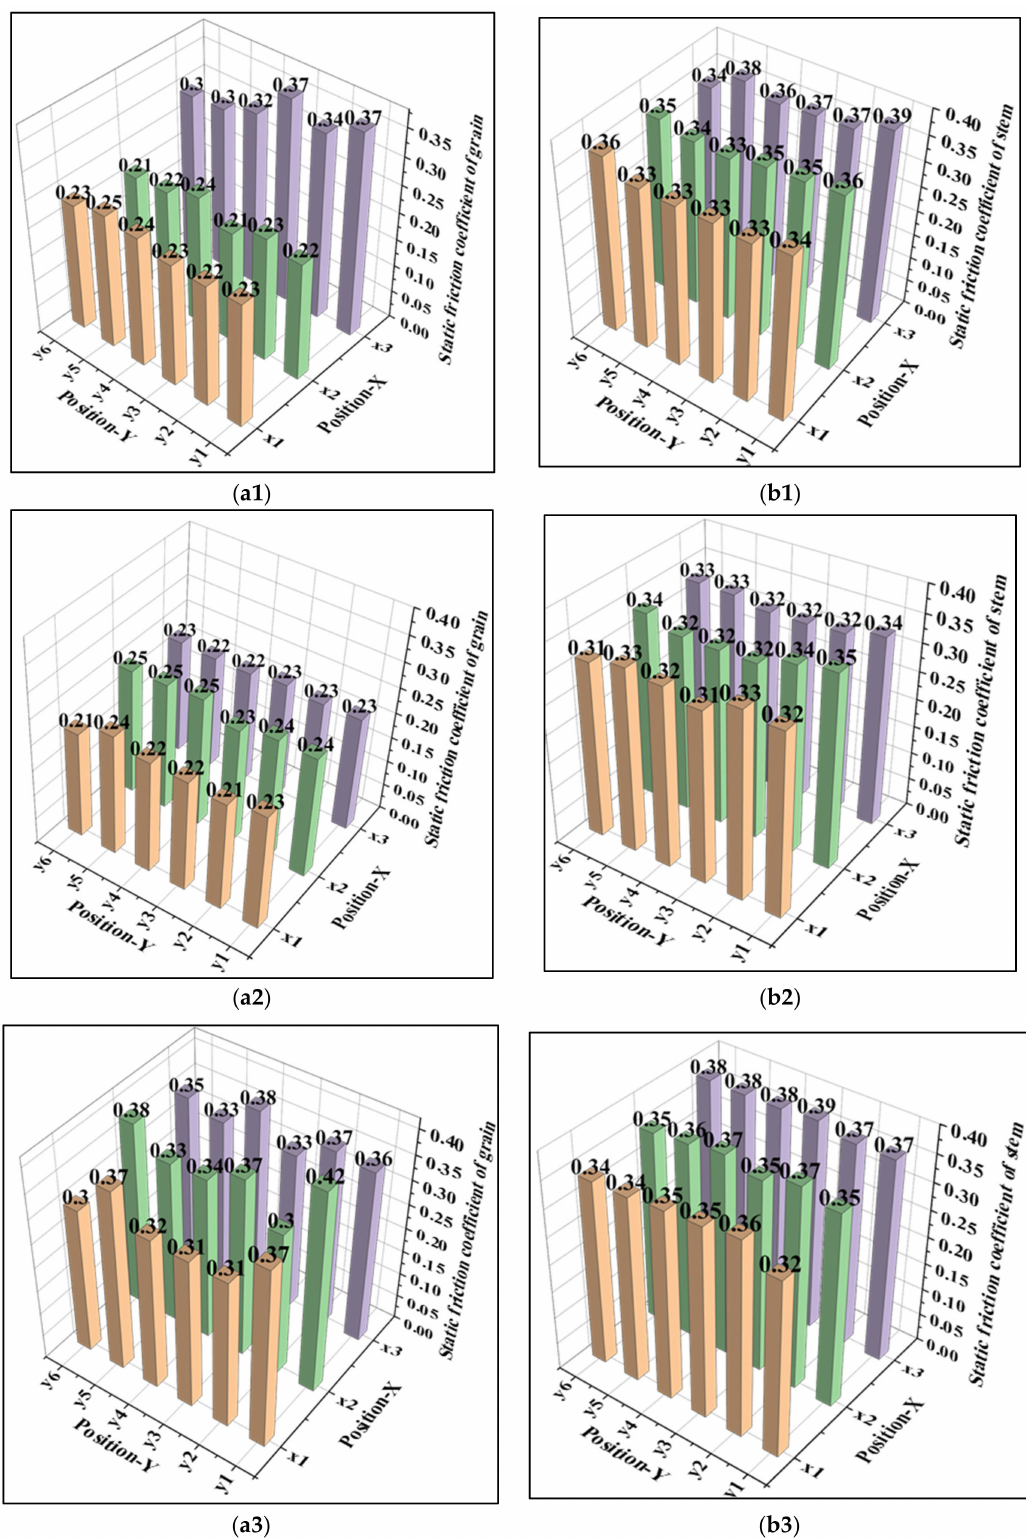
Figure 5. Average static friction coefficients of rice grains and stems in different measurement periods: ( a1 ) and ( b1 ) morning; ( a2 ) and ( b2 ) afternoon; ( a3 ) and ( b3 )